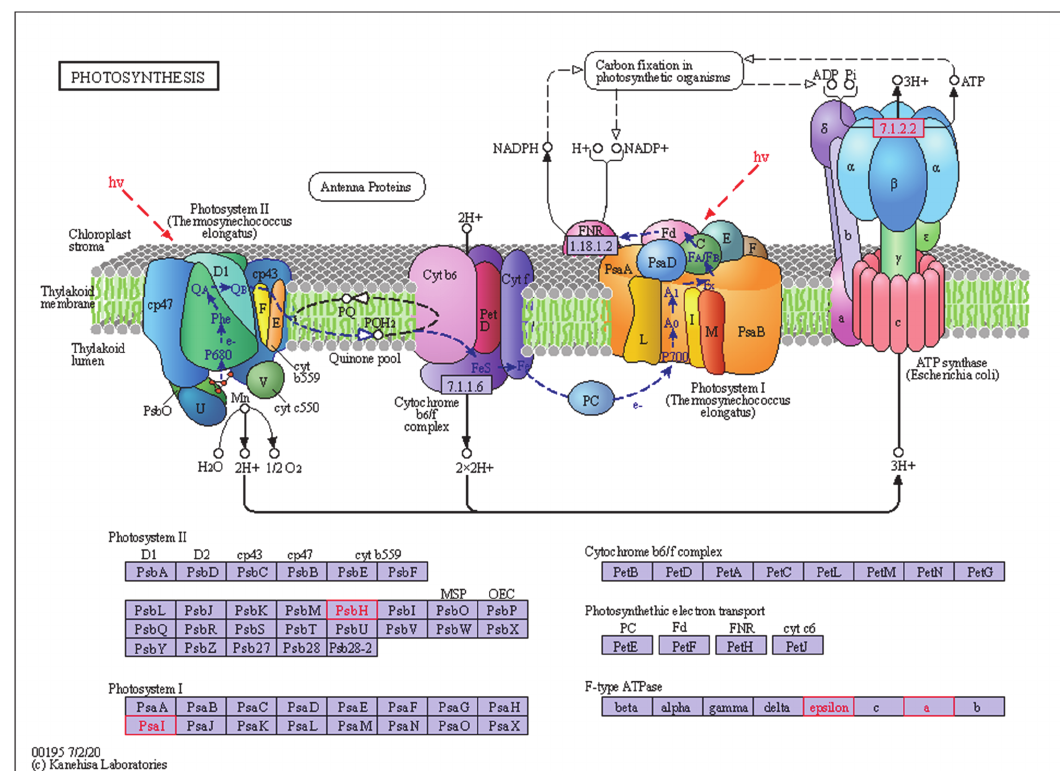
Figure 14. Details of Photosynthesis pathway.